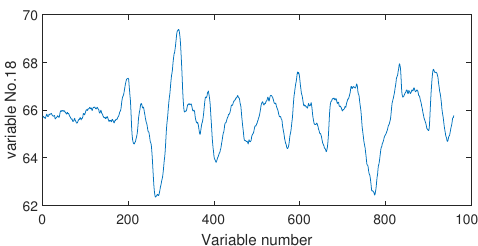
Figure 14. The variable trend (No. 18) when fault F10 occurs.